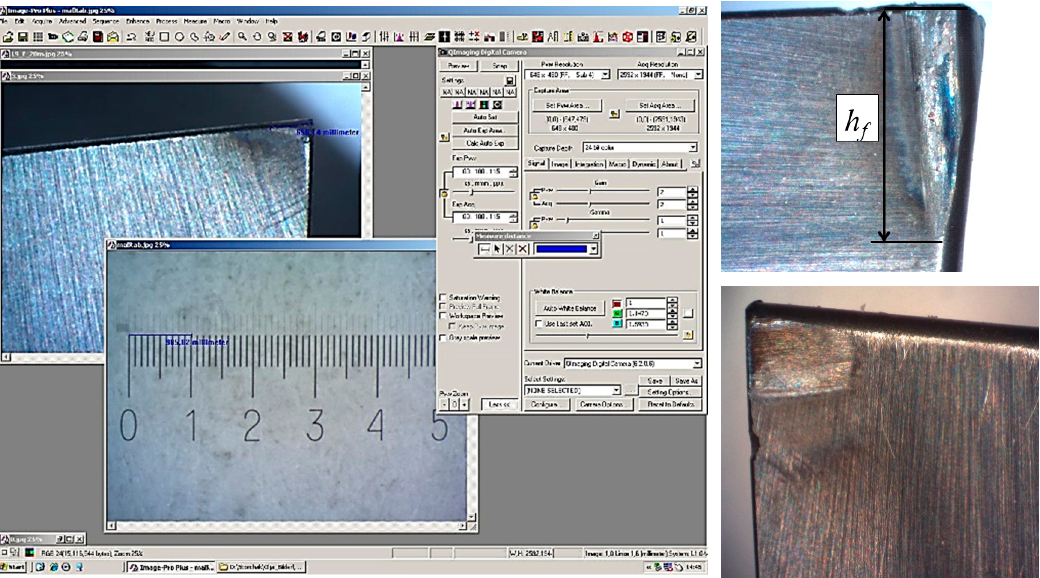
Figure 7. Photo of the data processing process results of a full-scale experiment with machining turning.